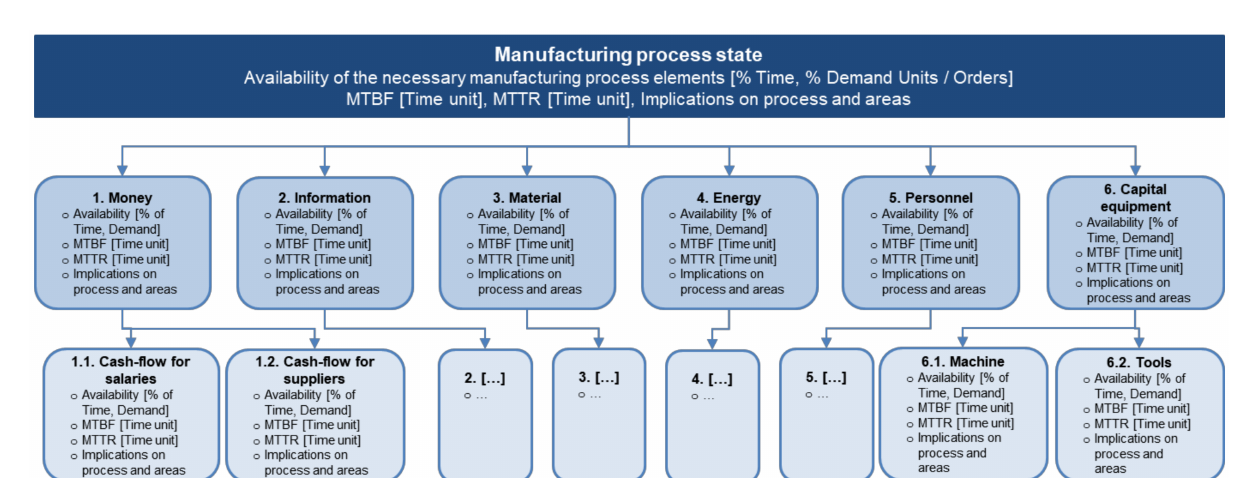
Figure 5. The manufacturing process element tree: state and indicators (own